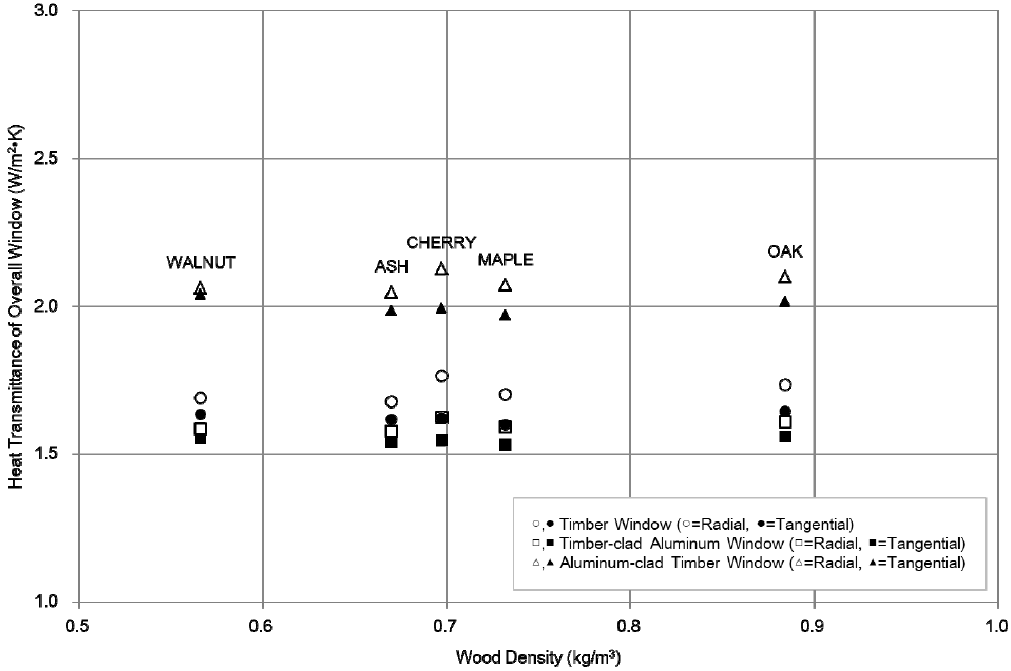
Figure 7. U-value of window components and overall window products compared.